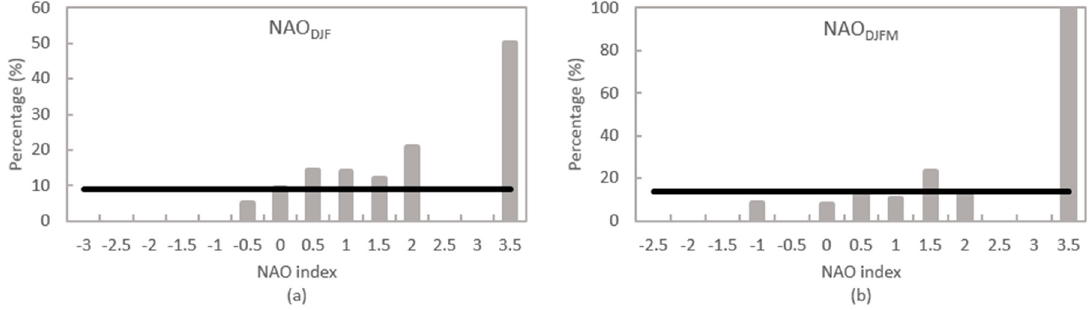
Figure 7. Percentage of pro-pluvia rogations celebrated in each interval of the NAO DJF ( a ) and NAO DJFM ( b ). Black line is the distribution of the null hypothesis for each case.